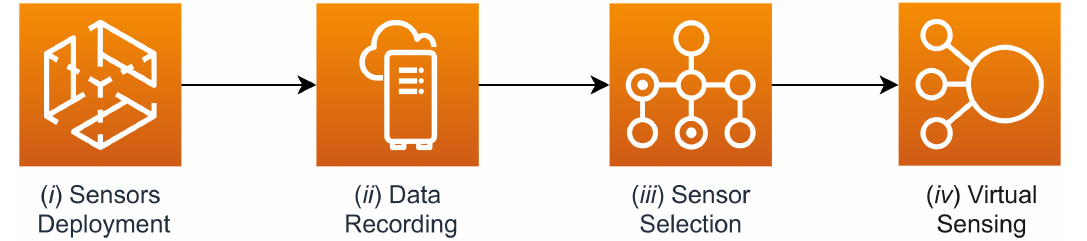
Figure 21. High-level steps which characterize the proposed